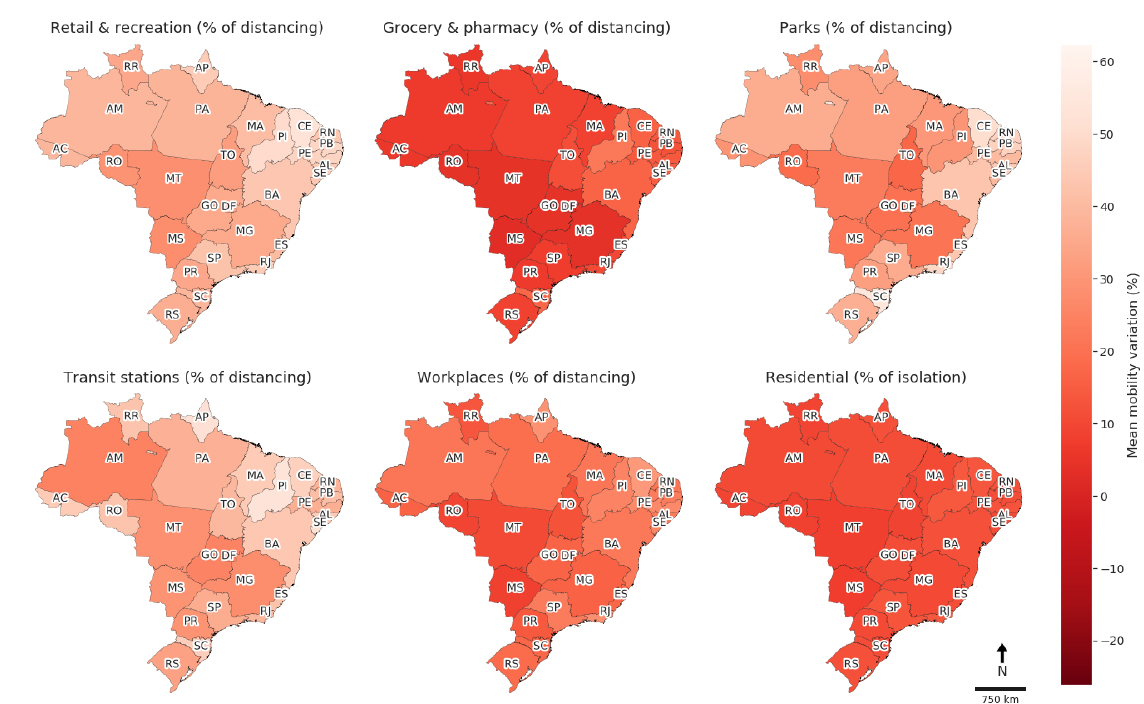
Figure 15. Average variation of mobility from baseline (3 January to 6 February 2020) for the states of Brazil during the period from 15 February to 31 May 2020. Lighter colours indicate greater distancing or greater isolation in residential areas. Source of basic data: Covid-19 Community Mobility Reports, Google.